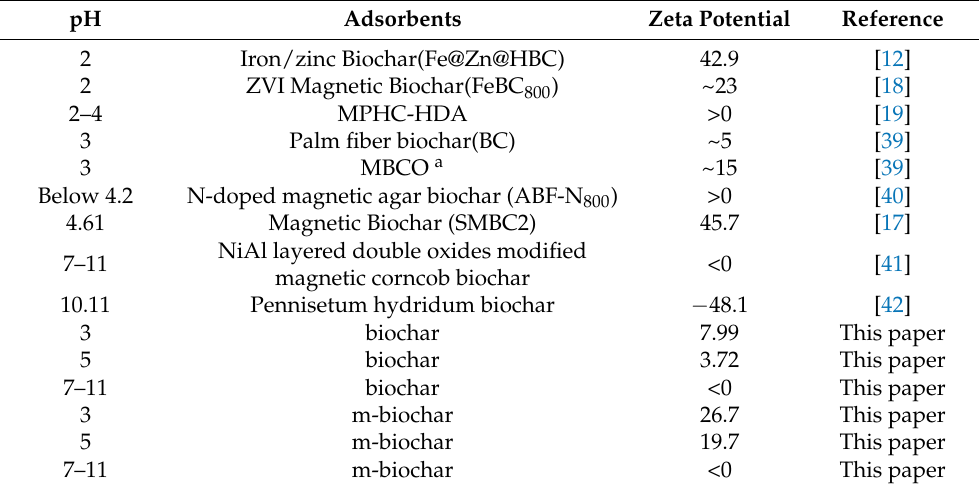
Table 4. Zeta Potential of different biochar adsorbents under different pH